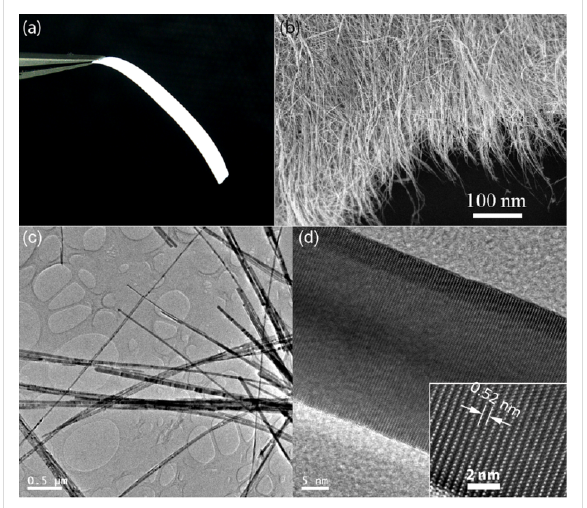
Figure 1: (a) An optical photograph of a strap-shaped ZnO nanowire film; (b) SEM image of the nanowire film; (c,d) TEM images of the